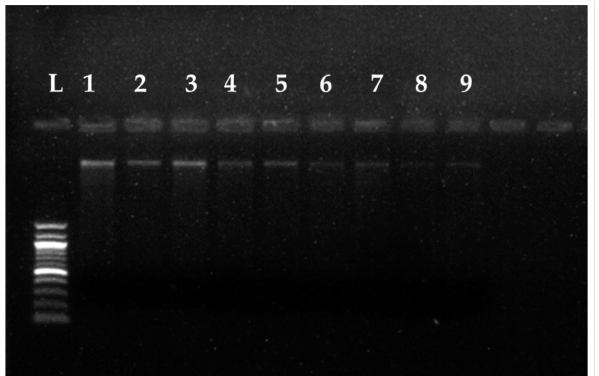
Figure 9. Fragmentation and degradation of the fungal genomic DNA on incubation with NaOH (RA)-derived ZnNPs. Lane L = Marker ladder, Lane 1 = gDNA of Fusarium oxysporum ( FO ), Lane 2 = gDNA of Curvularia lunata ( CL ), Lane 3 = gDNA of Macrophomina phaseolina ( MP ), Lane 4 = FO gDNA incubated with ZnNPs for 2 h, Lane 5 = CL gDNA incubated with ZnNPs for 2 h, Lane 6 = MP gDNA incubated with ZnNPs for 2 h, Lane 7 = FO gDNA incubated with ZnNPs for 24 h, Lane 8 = CL gDNA incubated with ZnNPs for 24 h, Lane 9 = MP gDNA incubated with ZnNPs for 24